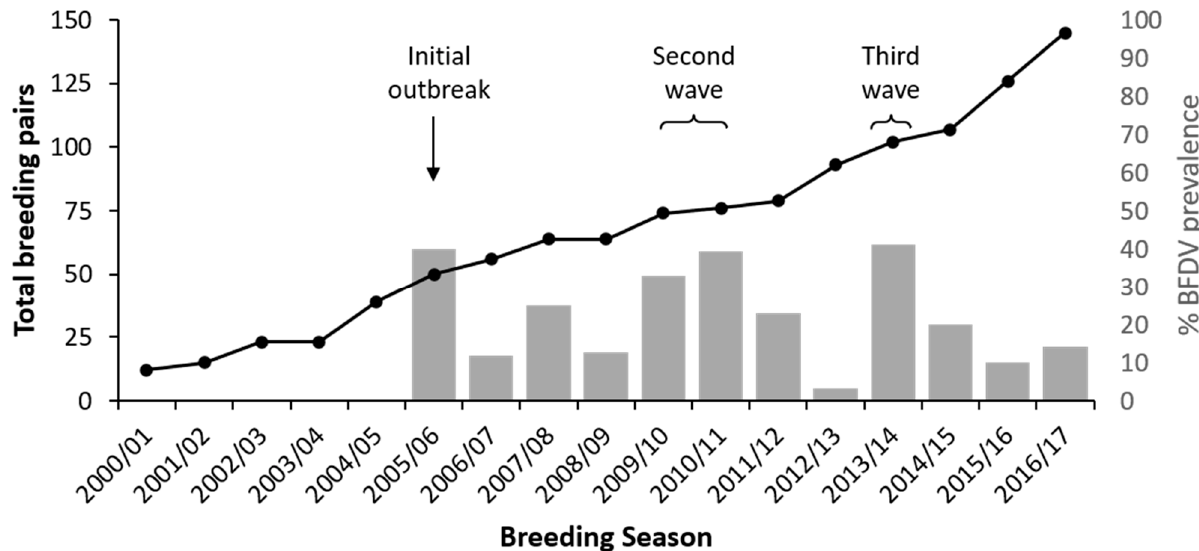
Figure 2. The total number of Mauritius parakeet breeding pairs recorded between 2000 and 2017 (black line) plotted with the percentage BFDV prevalence detected in offspring produced in each breeding season since systematic sampling began in 2005 (grey bars).